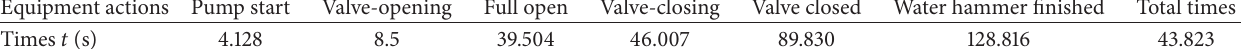
Table 2: Times of equipment in multistage valve-closing.